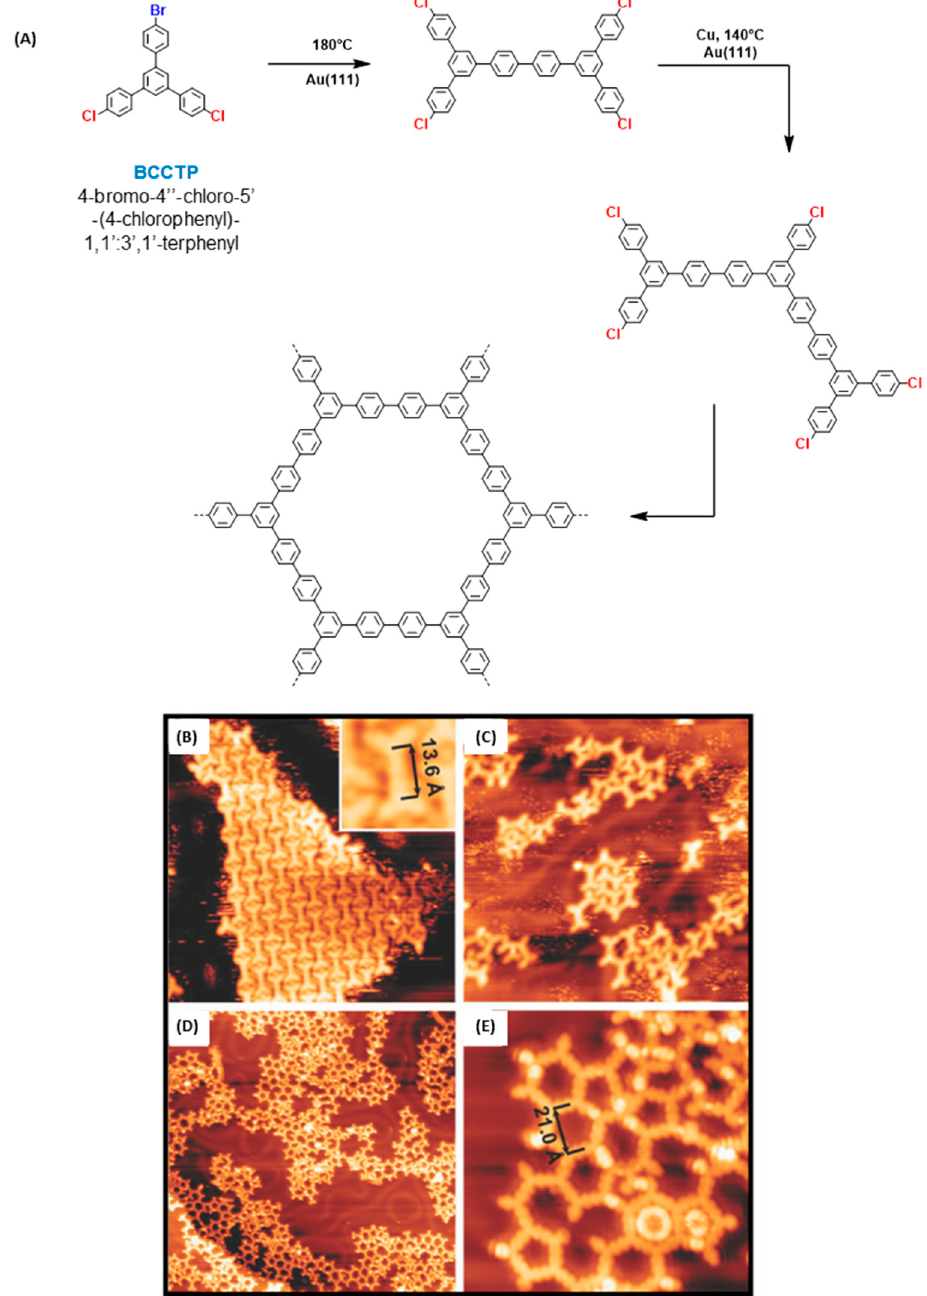
Figure 8. ( A ) Reaction pathway involved in the formation of hexagonal pores with BCCTP. ( B ) Evaporation of BCCTP on Au(111) substrates (26 nm × 26 nm with inset 3 nm × 3 nm). ( C ) Evaporation of the copper catalyst on a Au surface heated at 140 °C (26 nm × 26 nm). ( D , E ) STM images of the Au(111) substrate after annealing the surface at 280 °C at different magnifications (65 nm × 65 nm for ( D ) and 14 nm × 14 nm for ( E )). Adapted from [90] with permission from The Royal Society of Chemistry.